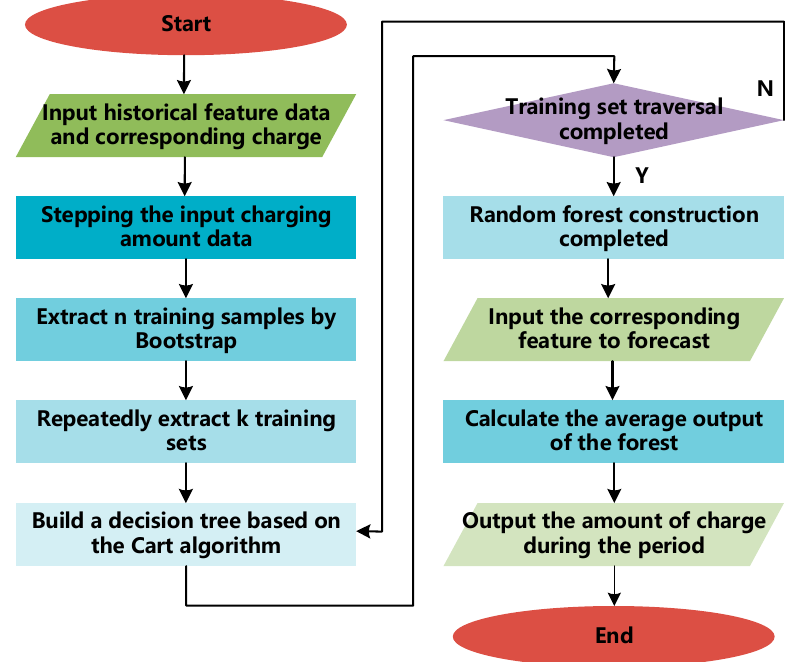
Figure 2. Flowchart of charging prediction algorithm.